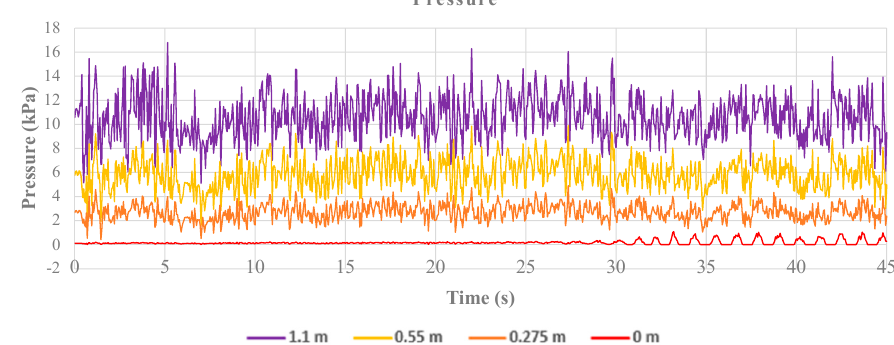
Figure 16. Pressure variation of smoothed particle hydrodynamics (SPH) at different depths with d = 1.1 and A = 50.5 mm.